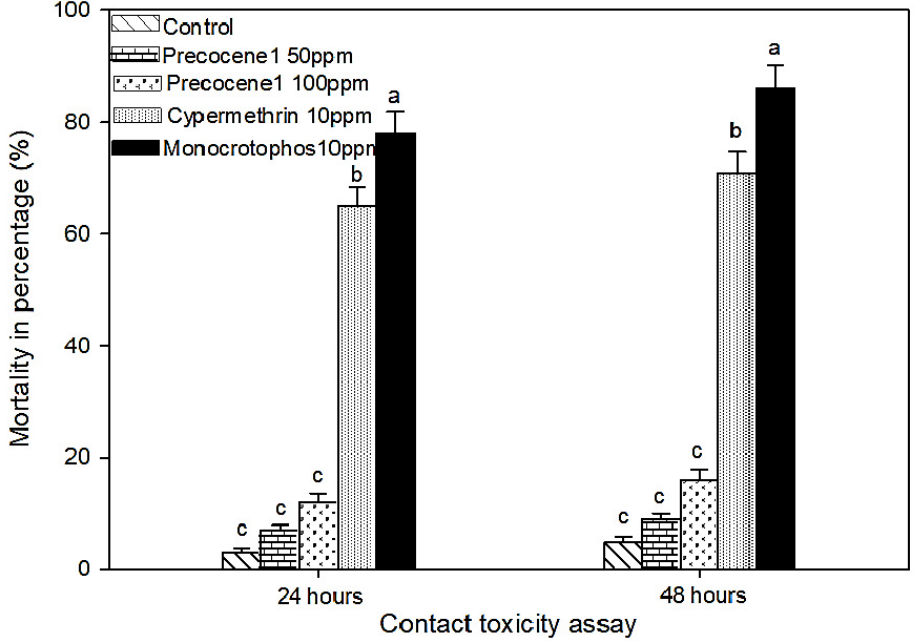
Figure 4. Percentage mortality of earthworm in filter paper test after treated with fraction VII and chemical pesticides. Means (± (SE) standard error) followed by the same letters above bars indicate no significant difference ( p ≤ 0.05) according to Tukey’s test.